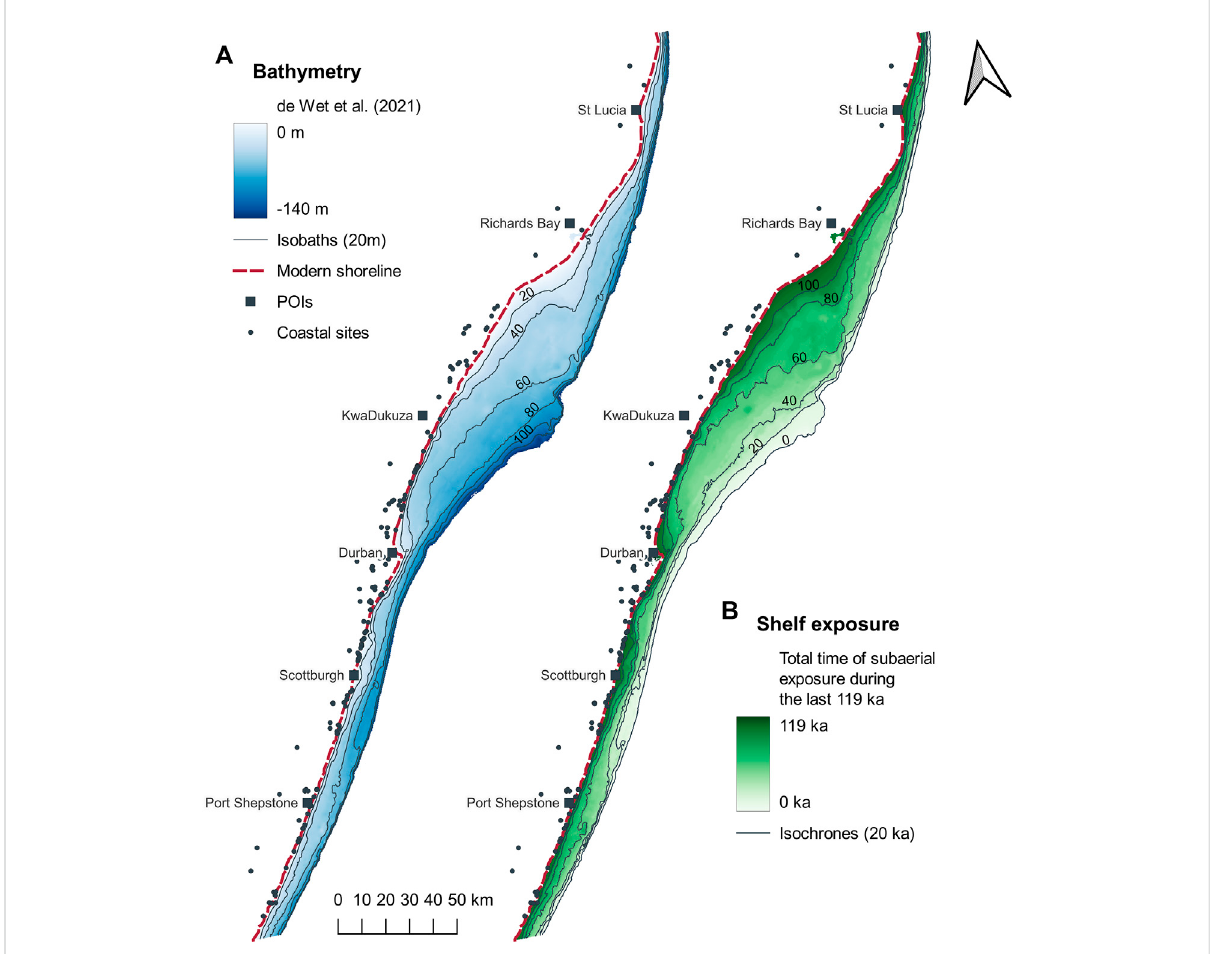
FIGURE 3 How long has the shelf been exposed during the last 119,000? (A) Bathymetric model by de Wet and Compton (2021) shows the modern-day water depths in the study area between 28.1 – 31.2 ° S in the sea level affected zone between 0 and 140 m. The result of the GIS model (B) shows the cumulative exposure time of the affected areas. The colours and isochrones indicate how long an area has been uncovered in total during the timeframe between 0 – 119,000 years ago. Note that the exposure time can be contiguous or the sum of multiple exposures, due to sea